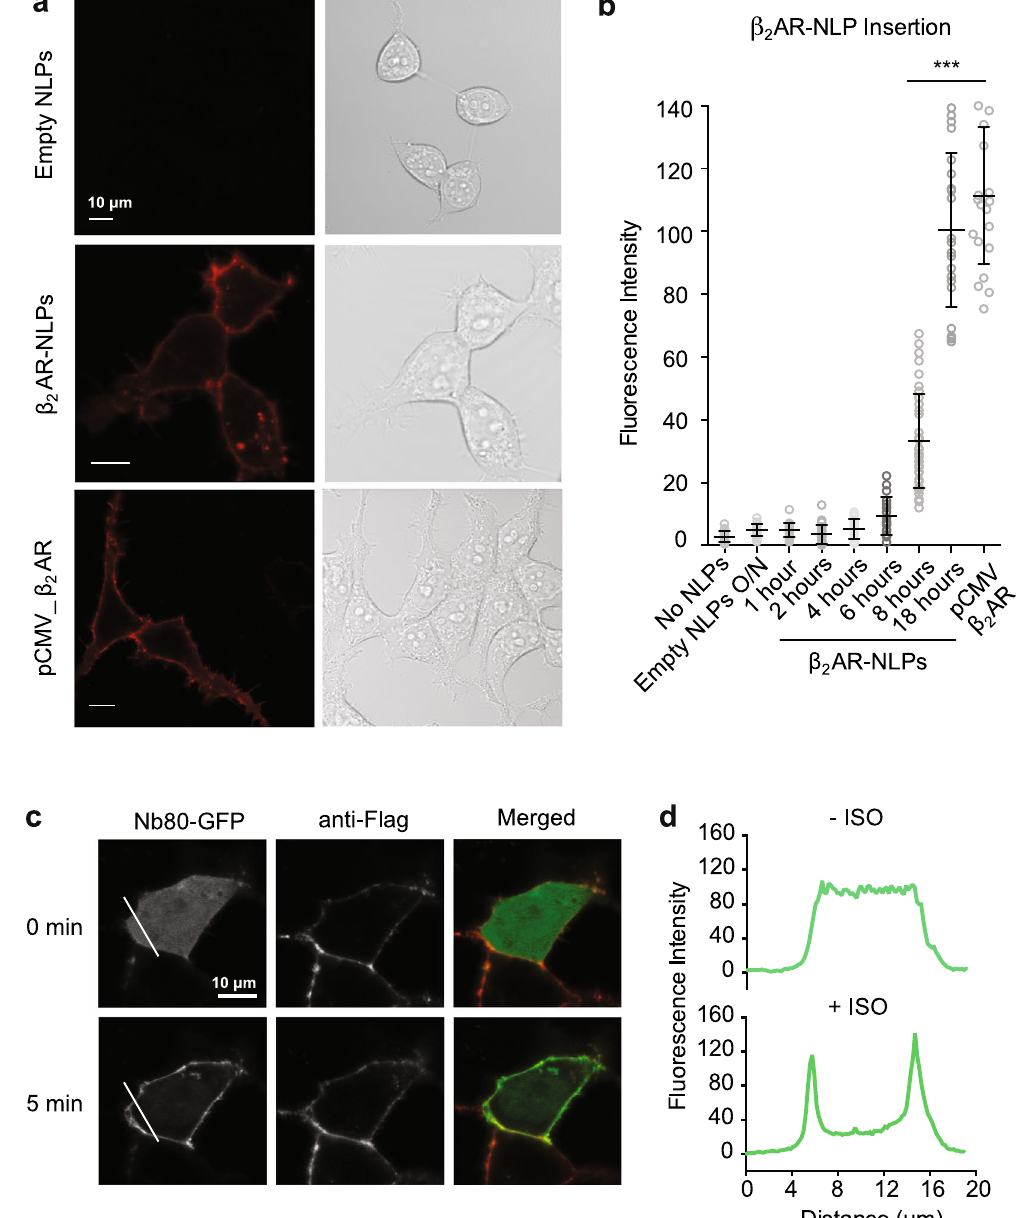
Figure 4. Nanodelivery of in vitro translated β 2 AR on cells. Time-course of β 2 AR-NLPs insertion onto HEK293 cell membranes was performed by live-cell anti-flag staining at various time points of incubation with β 2 AR- NLPs. ( a ) Representative fluorescence images showing flag staining intensity after 18 hours incubation. ( b ) Analysis of flag cell staining indicates efficient membrane insertion after overnight incubation (18 hours) (n = 20 cells, p < 0.0001). Results are shown as mean ± S.E. ( c ) Isoproterenol induced membrane-relocalization of Nb80-GFP in HEK293 cells after β 2 AR nanodelivery (18 hours, n = 8 cells). ( d ) Representative traces of fluorescence from line indicated in c